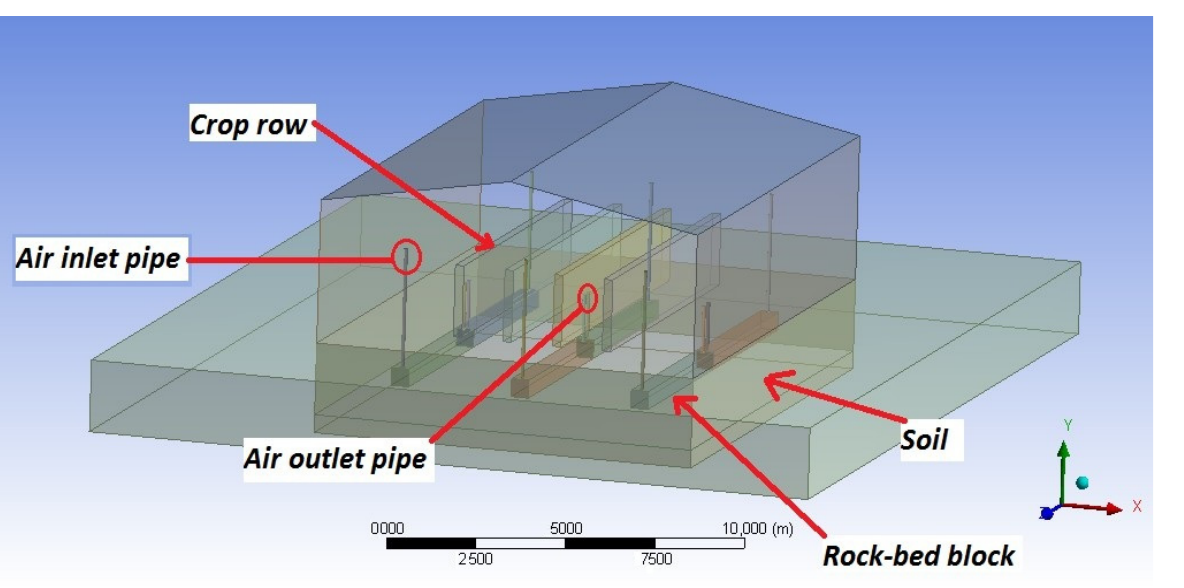
Figure 1. Greenhouse geometry and rock bed heating system. Three-dimensional coordinates represent x as east, y as zenith, and z as south.